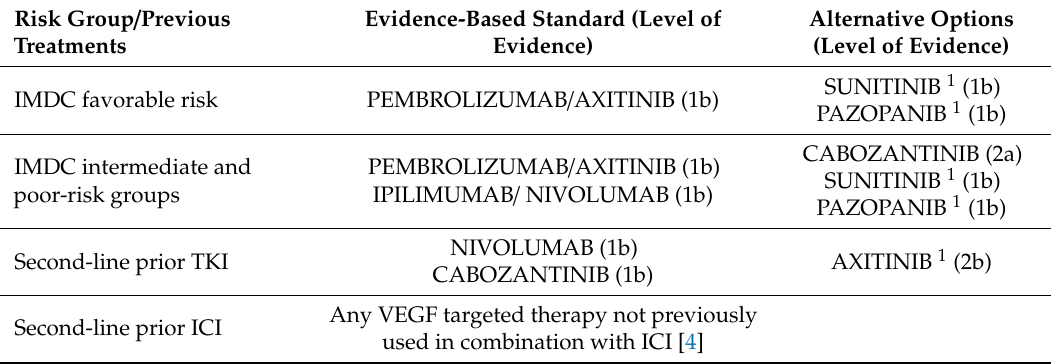
Table 1. Treatment recommendations for first-line and second-line therapy of metastatic clear cell renal cell carcinoma according to the Updated European Association of Urology Guidelines on Renal Cell